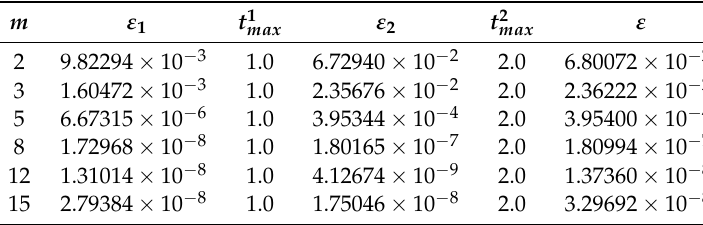
Table 1. Results for the problem